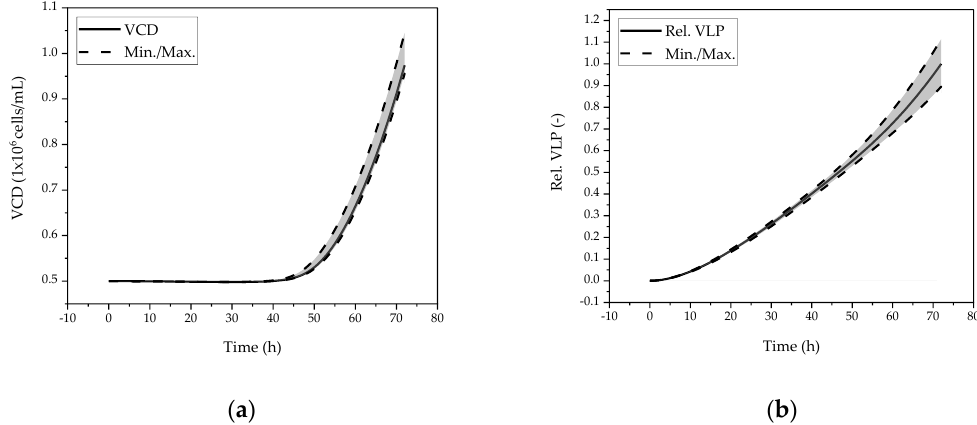
Figure 9. Monte Carlo Simulations using the Optimal Operating Point (derived from DoE) for initial substrate concentrations with a standard deviation of ±5%. ( a ) Viable cell concentration during initial batch phase, ( b ) normalized HIV-Gag VLP concentration.